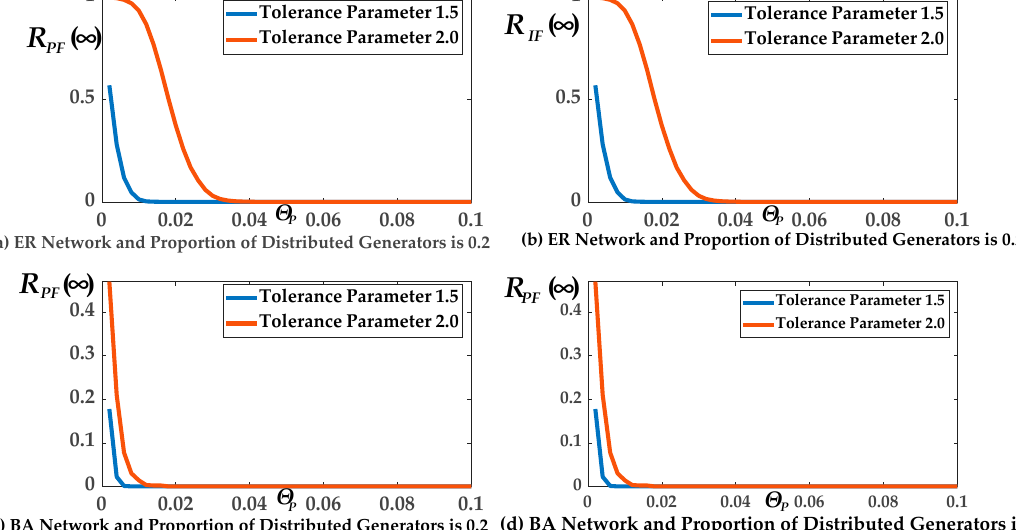
Figure 12. R PF ( ∞ ) / R IF ( ∞ ) of di ff erent tolerance parameters in the PN and CN.